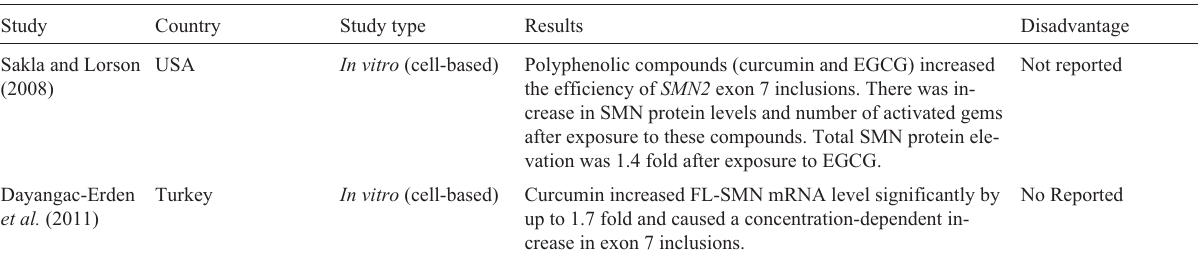
Table 11 - Summary of studies on curcumin and EGCG for the treatment of spinal muscular atrophy. Study Country